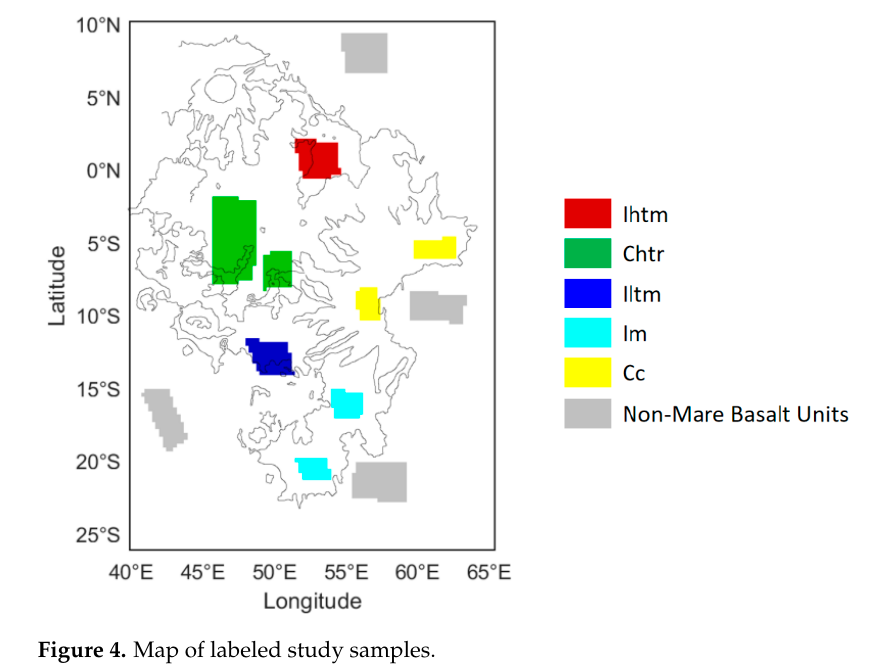
Figure 3. Map of Mare Fecunditatis by Kramer et al. in 2008 [30]. Ihtm: high-Ti mare basalt; Chtr: high-Ti spread (regolith); Iltm: low-Ti, mid-Fe HA (high alumina) candidate; Im: low-Ti, low-Fe HA candidate; Cc: obscuring crater ejecta.